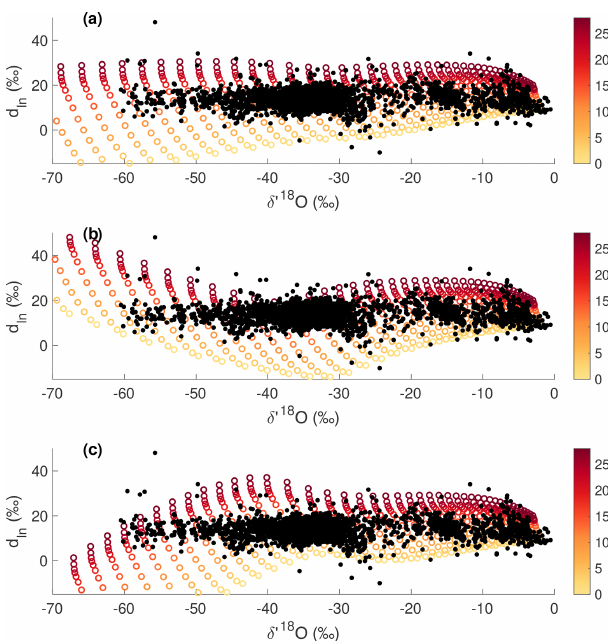
Figure A13. Comparison of tuned and rejected supersatura- tion parameterizations, S i = 1 − b × T . (a) Tuned example: b = 0 . 00525 ◦ C − 1 . Same as in Fig. A12a. The modeled δ 18 O and d ln of precipitation (colored circles) and target dataset (black dots). Color shading shows source region evaporation temperature in de- grees Celsius ( ◦ C). (b) Same as panel (a) , but for a rejected tuning: b = 0 . 003 ◦ C − 1 . The modeled d ln values curve upward strongly with δ 18 O, incongruently with the target data. (c) Same as panel (a) , but for another rejected tuning: b = 0 . 007 ◦ C − 1 . The modeled d ln values curve downward strongly with δ 18 O and incongruently with the target